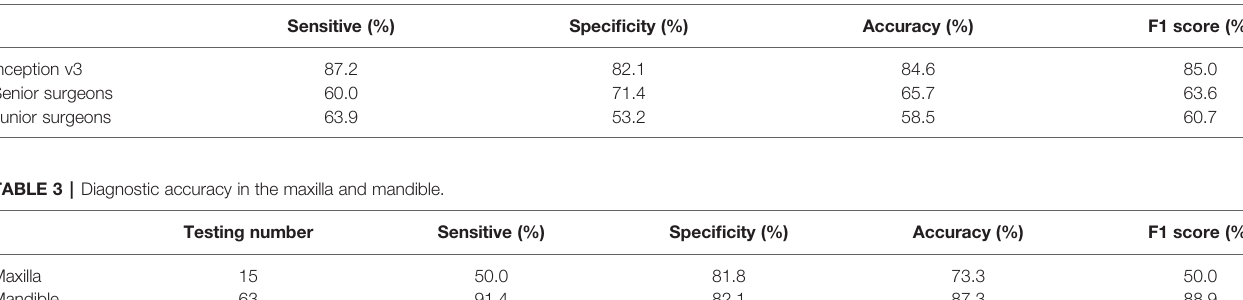
TABLE 2 | Comparison results of Inception v3 and surgeons.